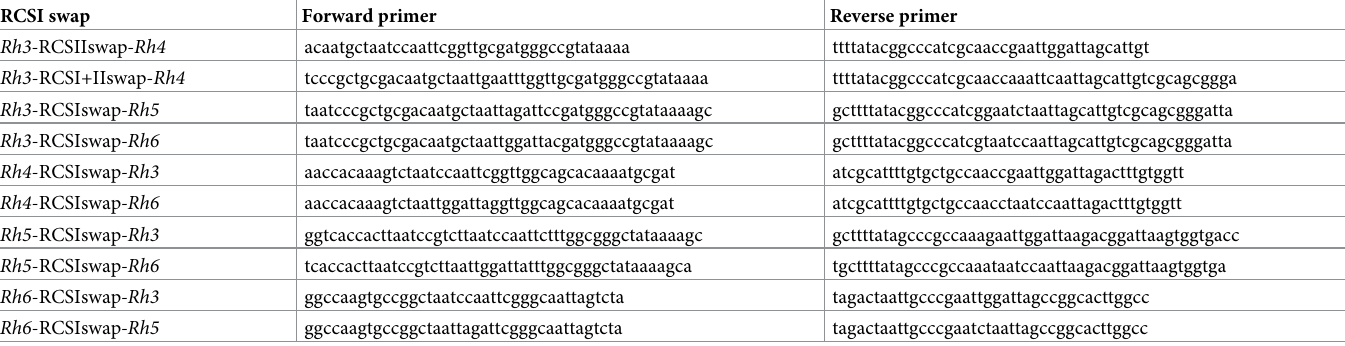
Table 2. Primers for generating RCSI and RCSII swaps. We performed the RCSI and RCSII swaps on the minimal rhodopsin promoters [19]. RCSI